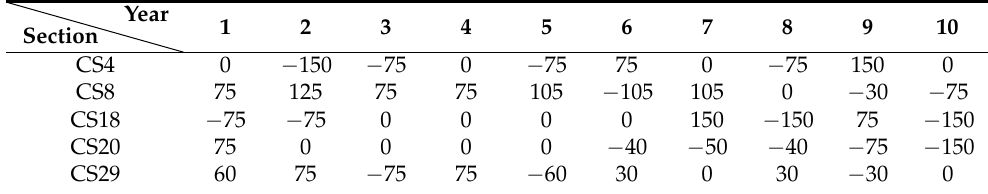
Table 6. Swing distance of each section year by year with nine river training projects (unit: m).